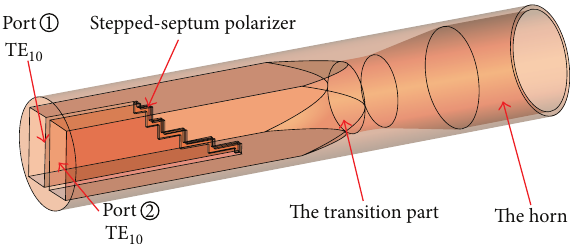
Figure 2: The holistic configuration of the horn antenna.